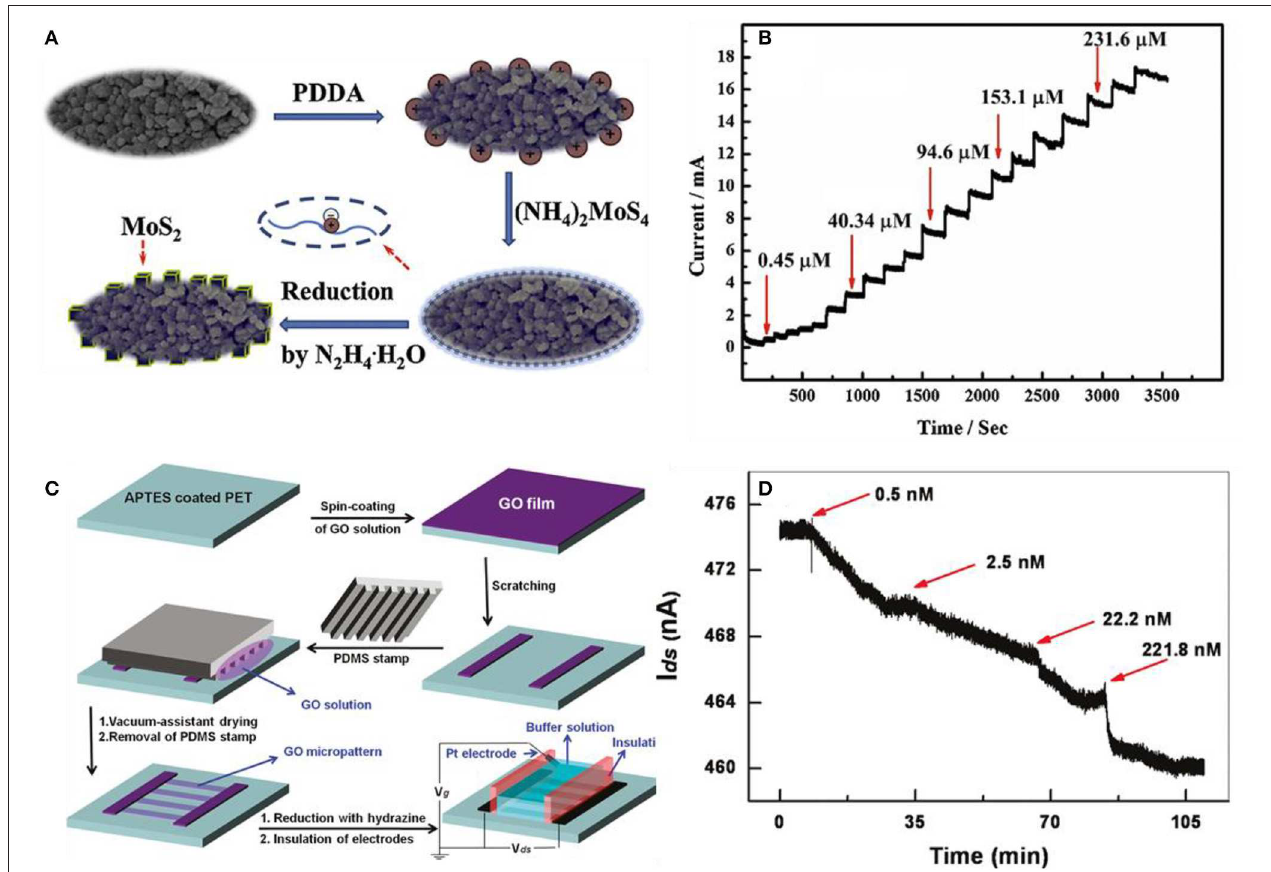
FIGURE 11 | p-type MoS 2 nanocube modified poly(diallyl dimethylammonium chloride)–mesoporous carbon composite for the L-cysteine sensor. (A) Schematic illustration of depositing MoS 2 nanoparticles on mesoporic carbon (MC). After coating poly(diallyl dimethylammonium chloride) on MC, MoS 2 is decorated by reducing MoS − 4 . (B) Response curves to various concentrations of L-cys at the MoS 2 /PDDA-MC/GCE composite in 0.1M phosphate buffer solution. Figures (A,B) were reproduced from Zheng et al. (2015) with permission from Elsevier. Pyrene functionalized RGO-based thin-film transistors (TFT) for detection of fibronectin. (C) Fabrication process of RGO based TFT. (D) Fibronectin detection by the increase of concentration at the pyrene-functionalized RGO TFT sensor. Figures (C,D) were reproduced from He et al. (2011) with permission from the American Chemical